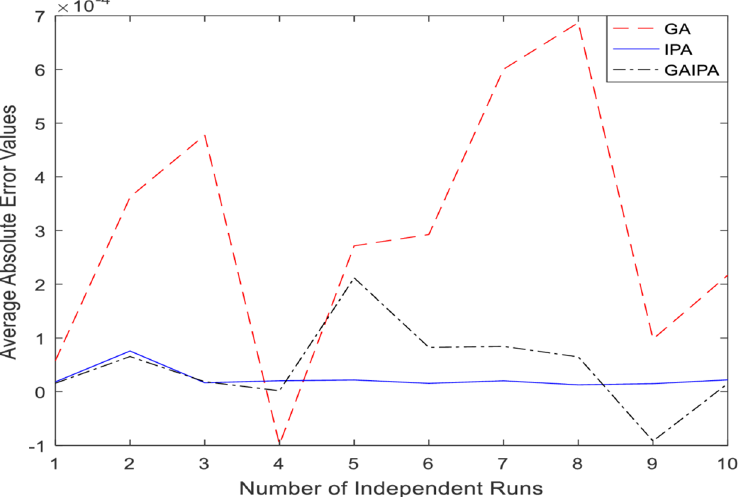
Fig 4. Graphical representation of average absolute errors for Example #02 when δ = 1.0 using Log Sigmoid.